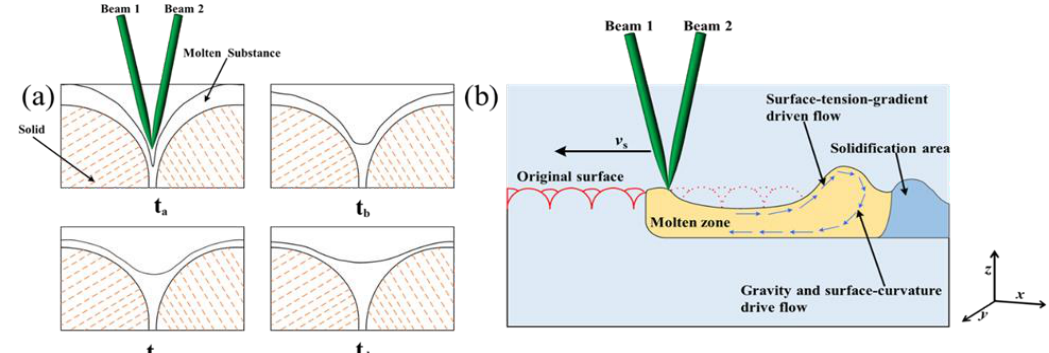
Figure 7. Schematic diagram of mechanism evolution of the SSM and SOM. ( a ) SSM, with the time sequence of t a , t b , t c , t d ; ( b ) SOM.